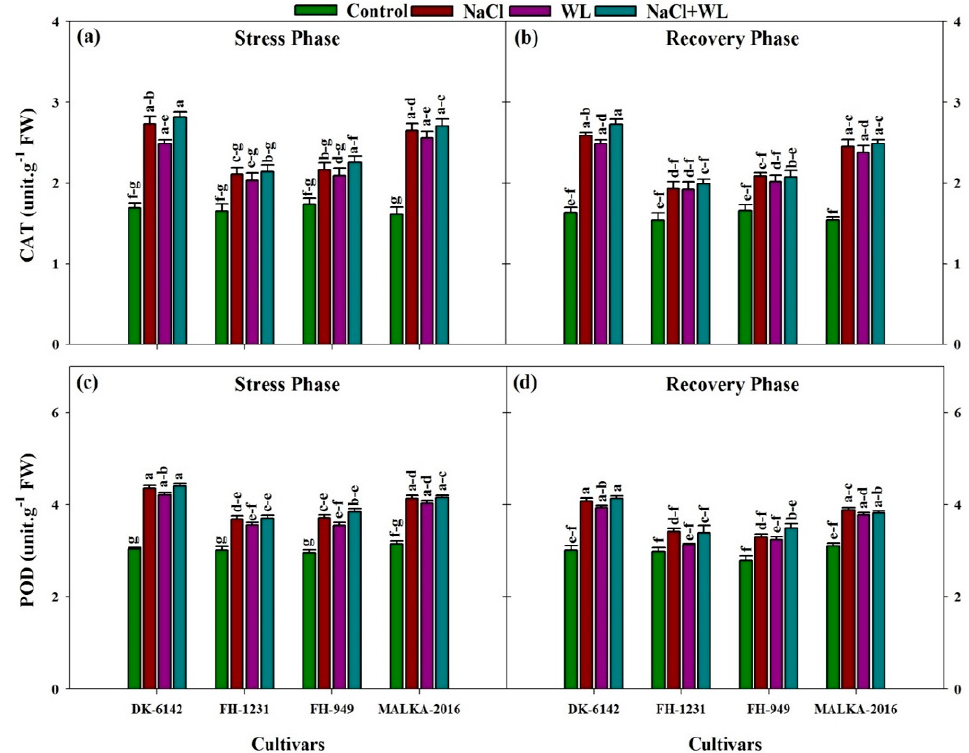
Figure 7. Individual and interactive effects of salinity and waterlogging on catalase (CAT) and peroxidase (POD) activity in four maize cultivars during the stress (22 DAS) and recovery (30 DAS) phases. Left and right sides of the figure are representing stress phase and recovery phase respectively. Error bars denote the standard error of three replications. Bars with same letter do not differ significantly at p ≤ 0.05.